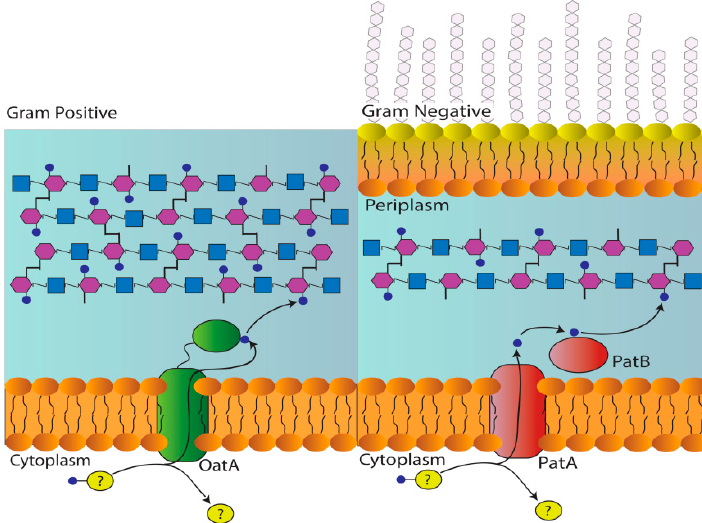
Figure 1. Pathways for the O-acetylation of PG. In Gram-positive bacteria, the membrane-spanning N-terminal domain of OatA receives an acetyl group from an unknown donor and translocates it across the cytoplasmic membrane for its transfer to PG by the extracytoplasmic C-terminal O- acetyltransferase domain. With Gram-negative bacteria, the two reactions are catalyzed by separate proteins. As an integral membrane protein, PatA translocates the acetyl group across the cytoplasmic membrane, while cytoplasmic PatB catalyzes its transfer to PG.